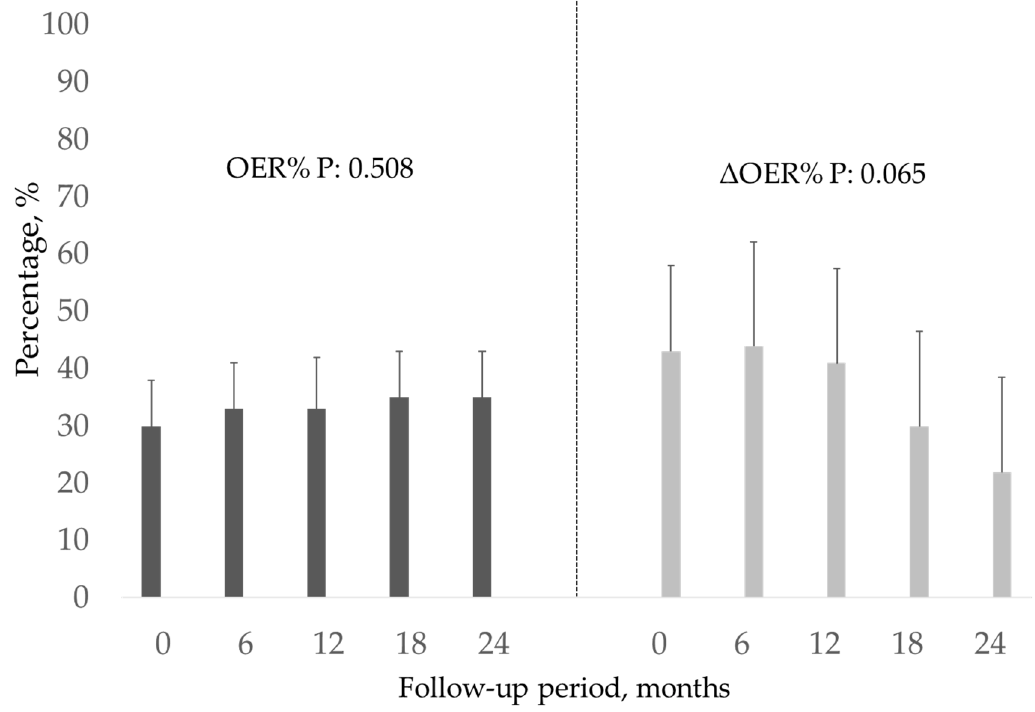
Figure 1. OER pre-HD and ∆ OER during the follow-up. OER, oxygen extraction ratio; ∆ OER, variation in OER.